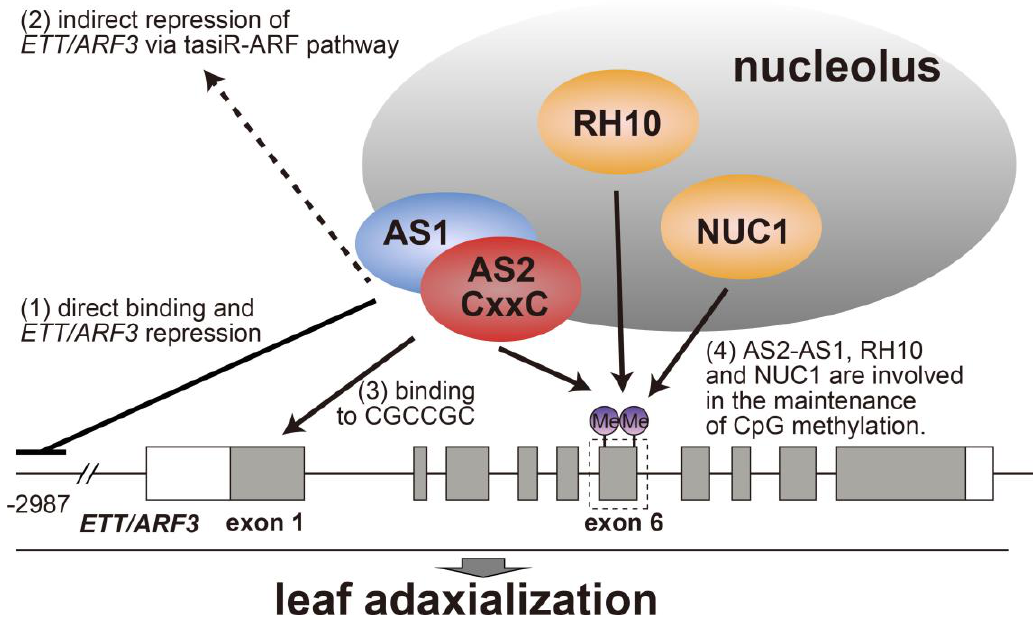
Figure 5. Molecular relationships between AS2–AS1 and the target gene ETT / ARF3 . AS1–AS2 directly binds the ETT / ARF3 regulatory region and represses ETT / ARF3 expression. AS2 binds to the specific CGC repeat sequence in exon 1. AS2–AS1, RH10, and NUC1 are involved in the maintenance of CpG methylation in exon 6. RH10 and NUC1 are proteins localized in the nucleolus.